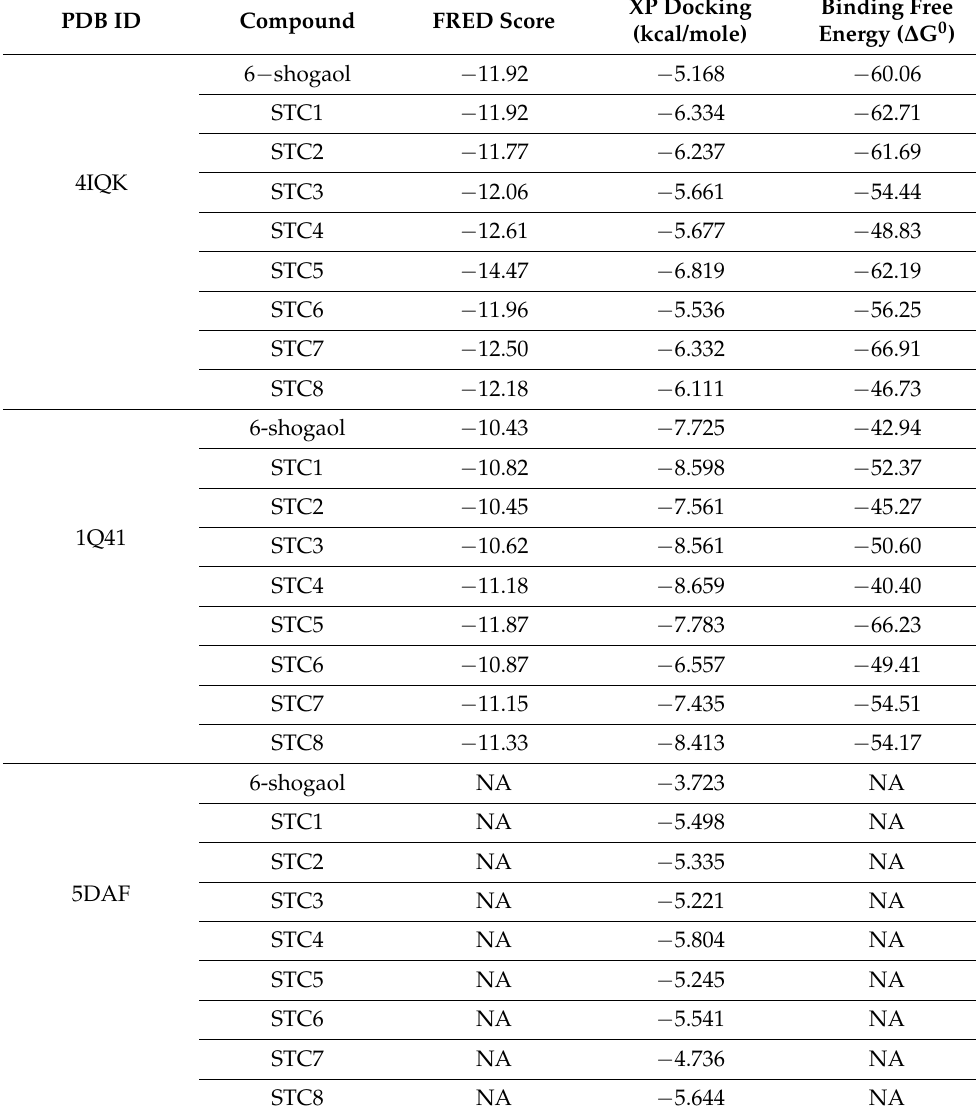
Table 3. The docking scores (FRED score and XP score) and binding free energies ( ∆ G 0 ) of the test compounds in the binding pockets of 4IQK and